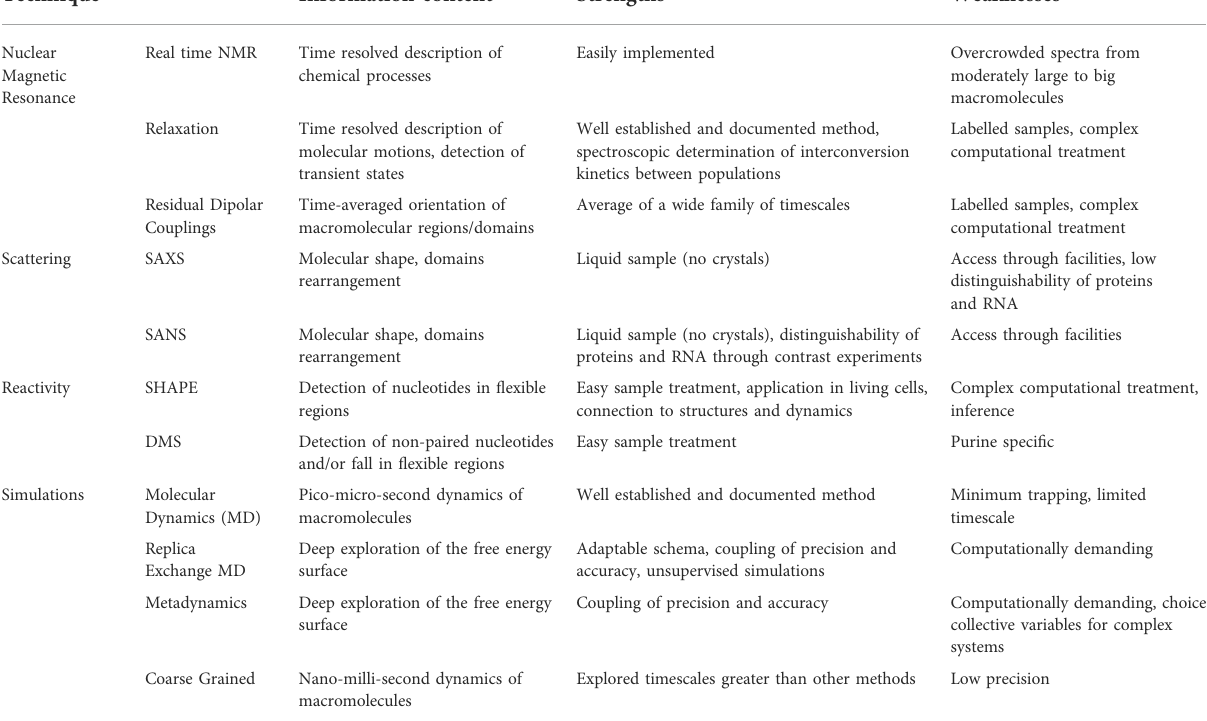
TABLE 2 Summary of biophysical techniques to study RNA